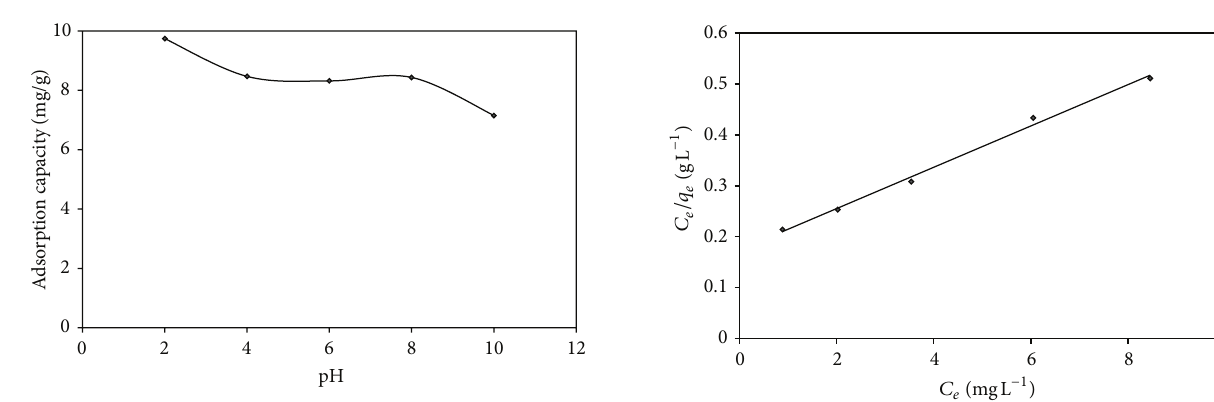
experiments are at the same temperature and at optimum pH constant for 30 min time intervals. As the dosage of adsorbent increases, the removal rate of RhB correspondingly increases from 34.8% to 90.6%. It is attributed to the greater surface area and availability of more active sites for adsorption while the increasing of adsorbent dosage, which lead to the increase of the removal rate of dye from the solution finally [44]. However, when the adsorbent dosage is 100 mg L −1 , more than 80% RhB has been removed from the solution.